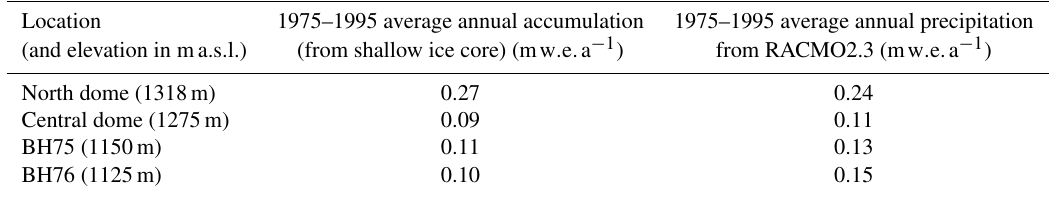
Table 1. Comparison of measured accumulation and modelled precipitation (RACMO2.3) for the period 1975–1995. Site location is shown in Fig.